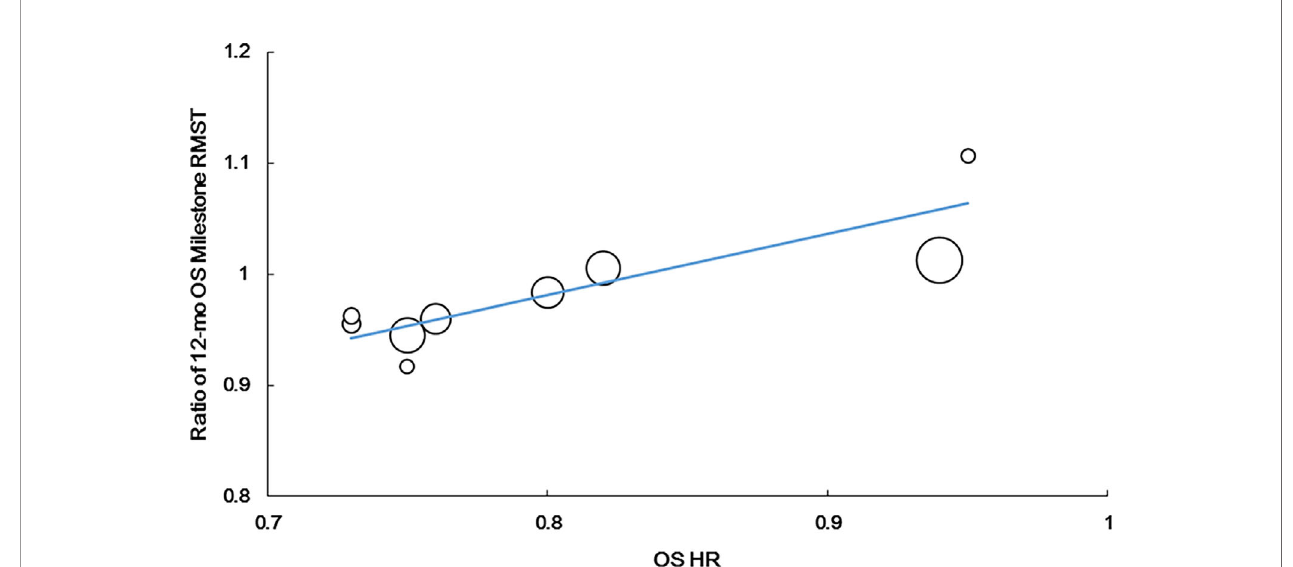
FIGURE 3 | Correlation of treatment effects on the overall survival (OS) hazard ratio (HR) with the ratios of 12-month OS milestone